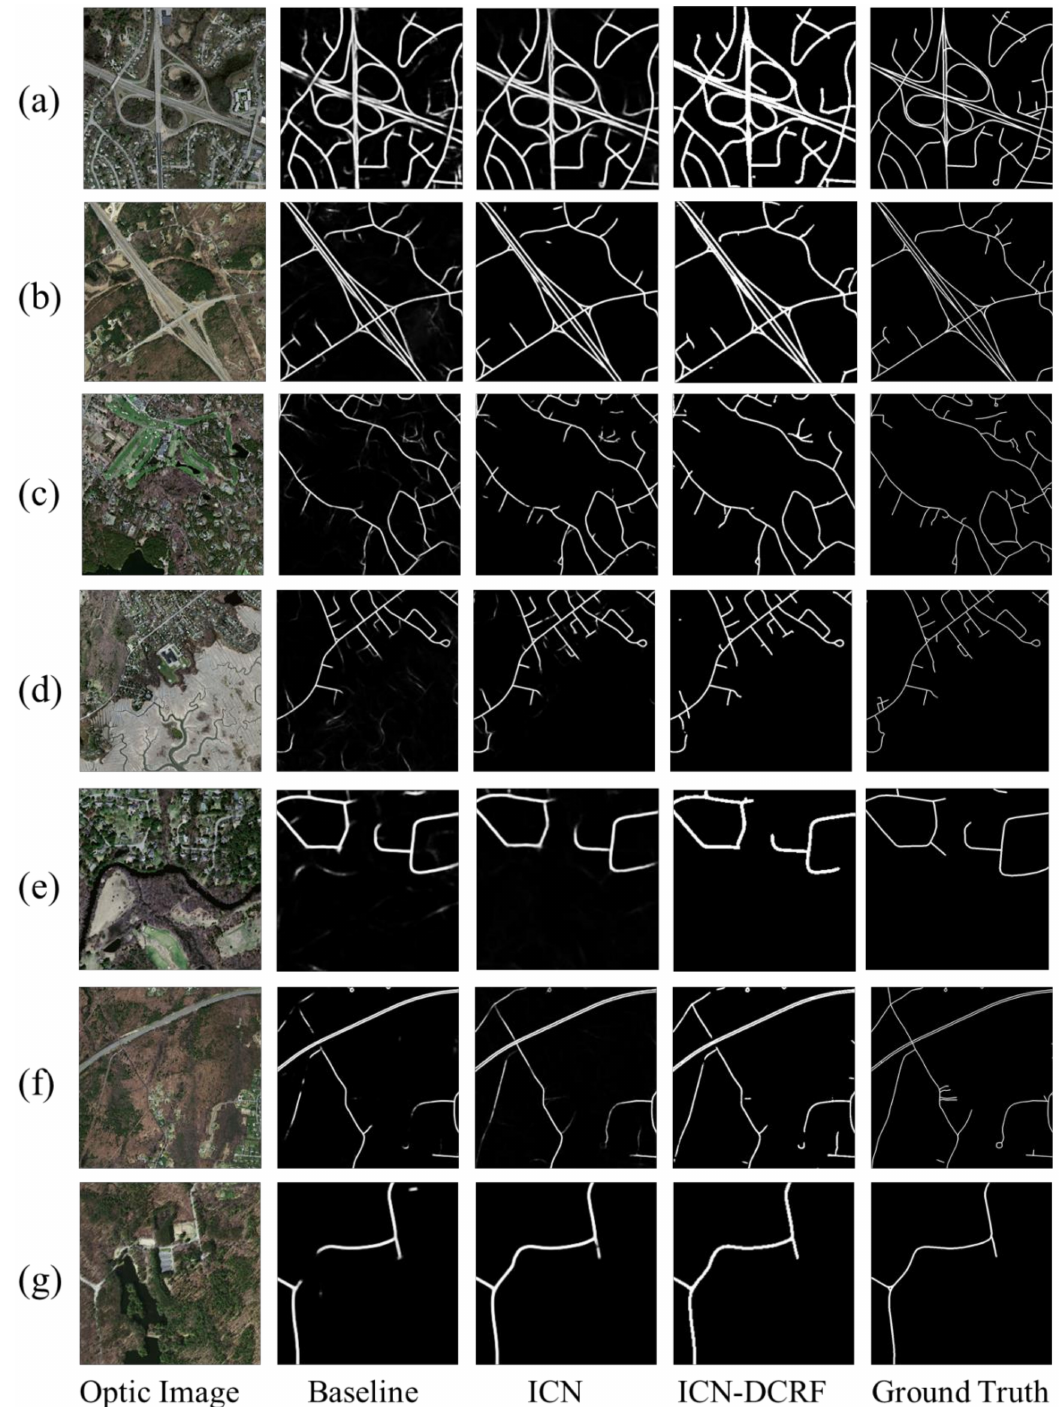
Figure 4. Visual comparisons of the ablation study using test samples from the Massachusetts roads dataset. Each row in ( a – g ) contains an RGB image, three result maps obtained by different models, and a ground truth map of a sample